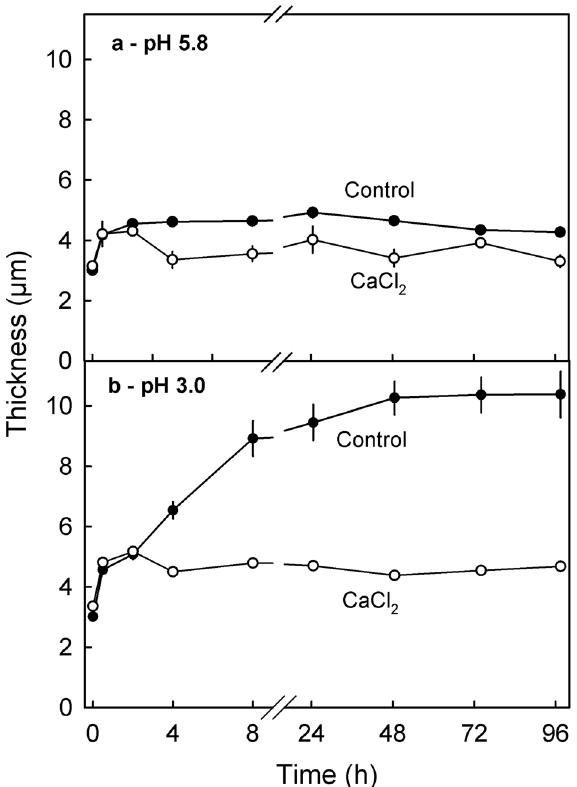
Figure 1. Time course of change in thickness of anticlinal cell walls of excised epidermal segments (ES) of mature ‘Santina’ sweet cherry fruit after a freeze/thaw cycle. The ES were incubated in buffered 10 mM CaCl 2 or in buffer only. The concentration of the MES buffer was 10 mM MES and the pH was adjusted to pH 5.8 ( a ) or pH 3.0 ( b